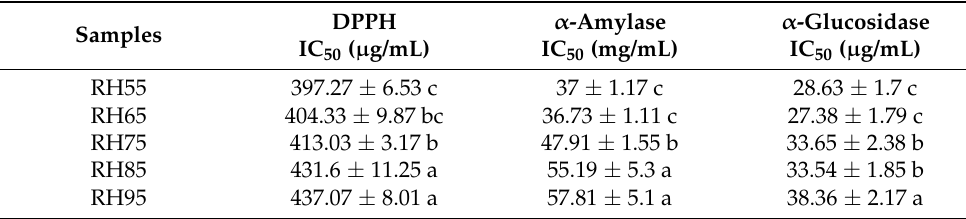
Table 3. DPPH scavenging and inhibition of α -amylase and α -glucosidase activities by congou black tea under different fermentation humidity